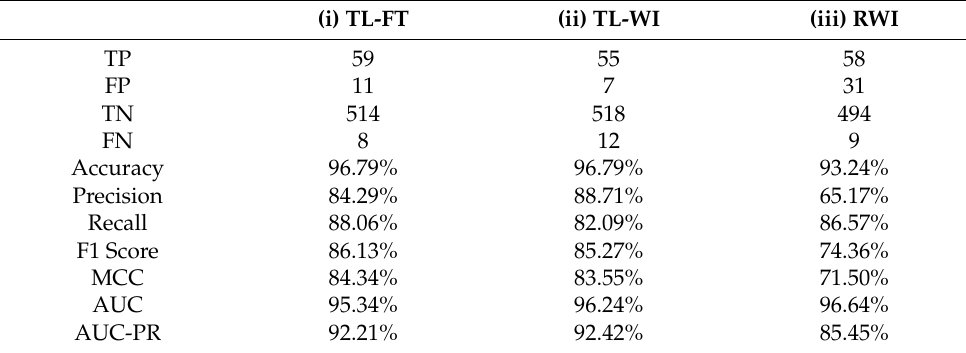
Table 4. Performance of our model with different weights initialization